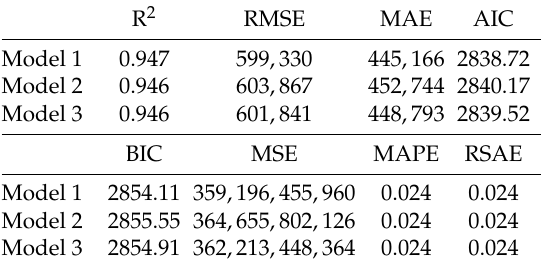
Table 3. Regression model